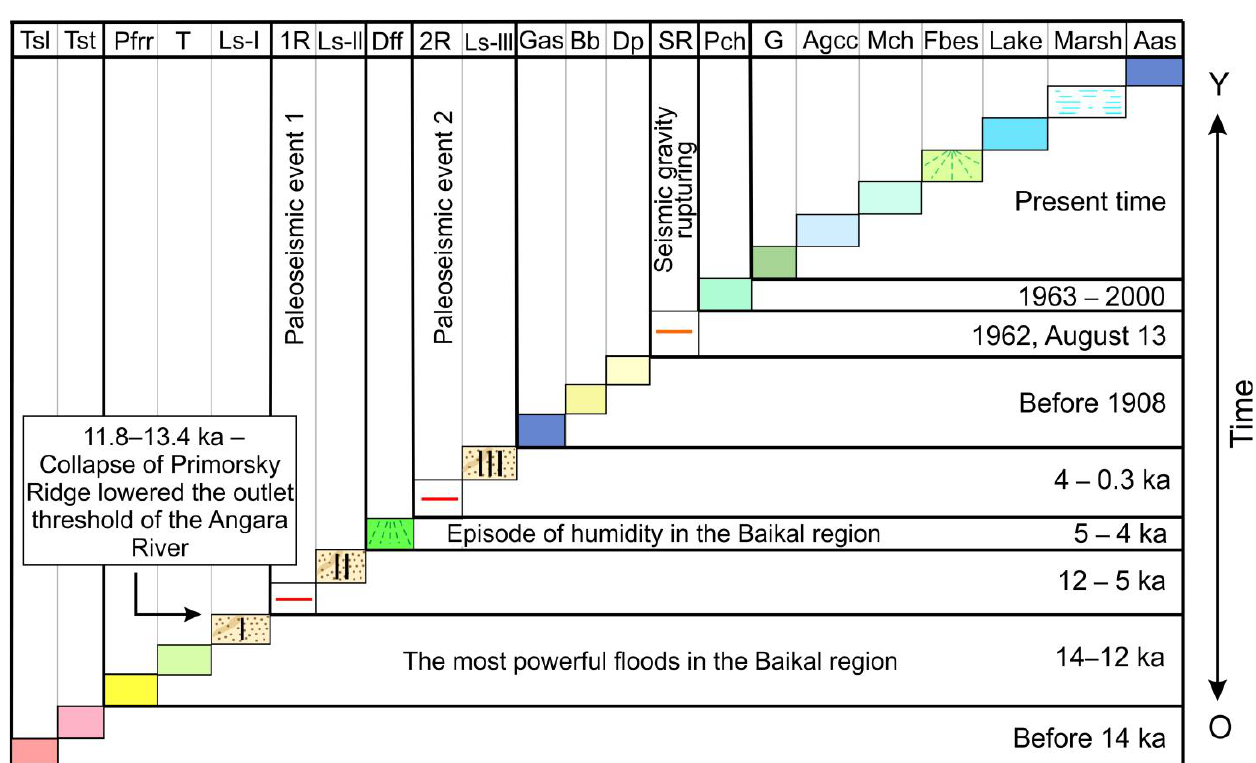
Figure 14. Age relationships of the mapped units in Figure 5 with the youngest at the top. Possible times of formation of units are indicated at the right. See text for further details. Tsl—tectonic slopes; Tst—tectonic step; Pfrr—Paleodelta plain (old fan of the Rita River); T—terrace of ~39 m high; Ls - I—landslide I; 1R—ruptures of first paleoseismic event activated later; Ls - II—landslide II; Dff—debris flow fans; 2R—ruptures of second paleoseismic event; Ls - III—landslide III; Gas– grass - covered abrasion scarp; Bb–braided bar; Dp—delta plain and floodplain; SR–seismic gravity ruptures; Pch—previous channels; G—gully, Agcc—accumulative gravel and cobbles coast; Mch—modern channels; Fbes—Fan and bottom of ephemeral stream; Aas—active abrasion scarp.